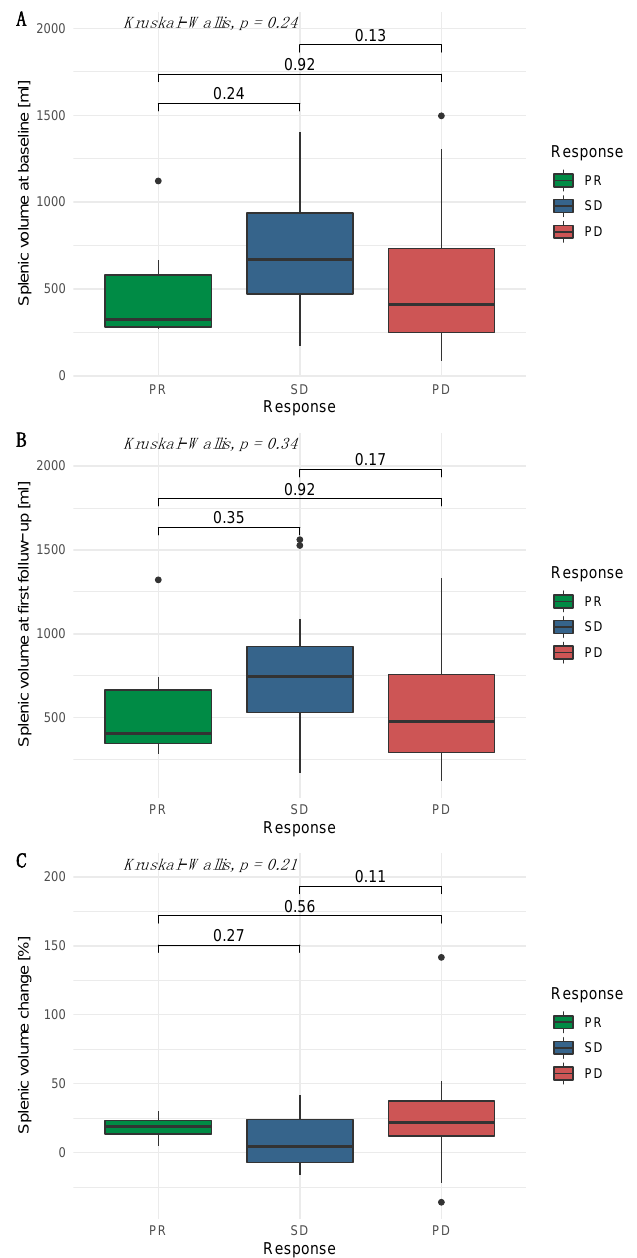
Figure 3. Splenic volume among the various response categories. ( A ) Baseline, ( B ) follow-up, and ( C ) relative change.